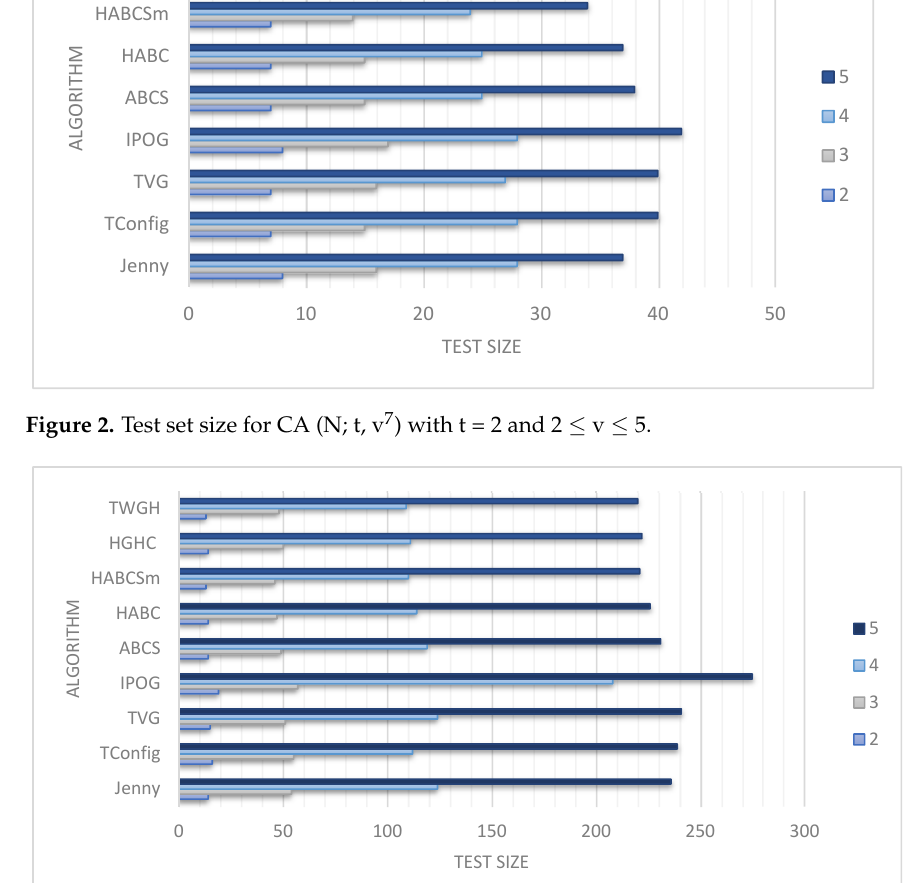
Figure 3. Test set size for CA (N; t, v 7 ) with t = 3 and 2 ≤ v ≤ 5.